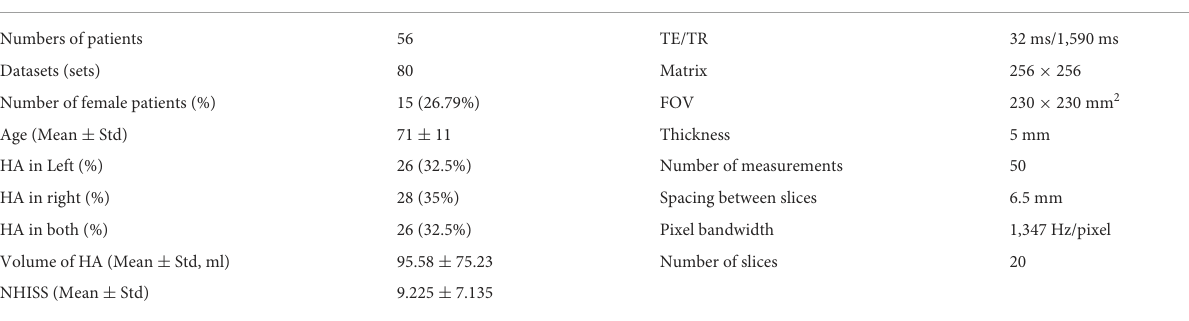
TABLE 1 Summary of patient information and the scanning parameters of DSC-PWI images. Information of